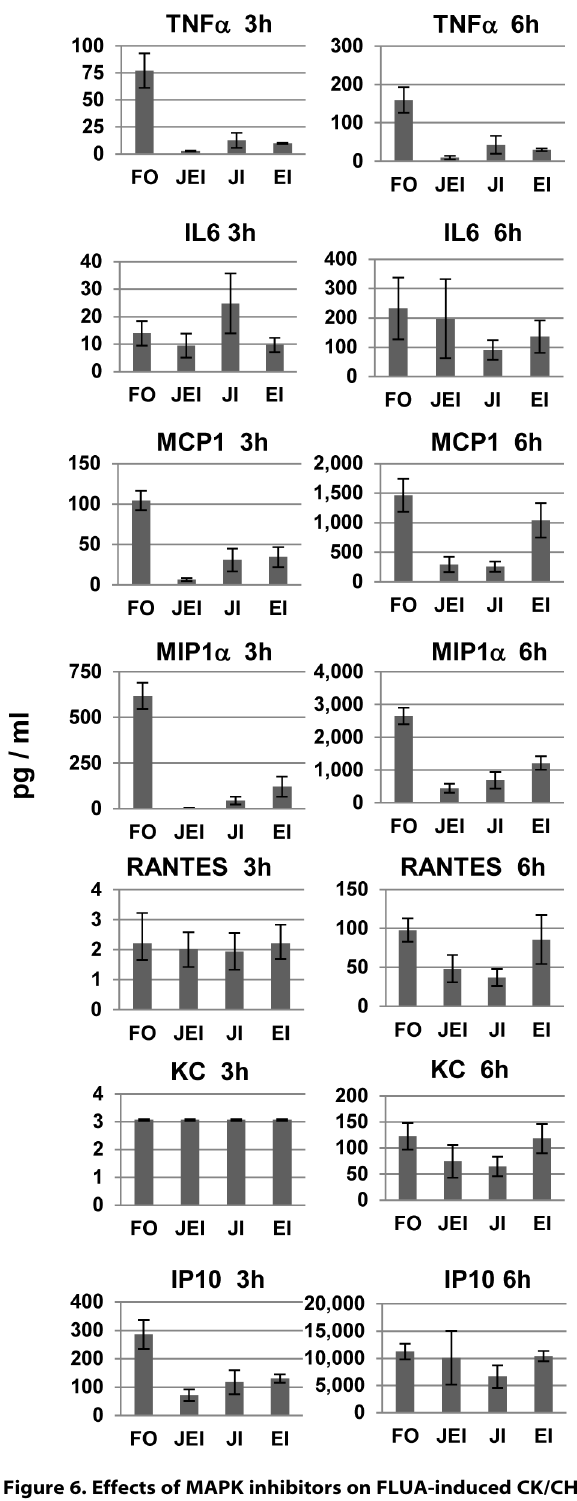
Figure 6. Effects of MAPK inhibitors on FLUA-induced CK/CHKs from J774.A1 cells at short time points. Supernatants from cells pre-treated with the indicated inhibitors for 1 h then exposed to FLUA were collected 3 or 6 h after exposure, along with those from mock infected controls. They were assayed for selected CK/CHK by multiplexed fluid phased antibody based analysis. Cytokine concentra- tions were calculated based on known concentration standards run at the same time. Data shown are the mean 6 SEM, n=3 independent experiments. FO–FLUA only; JEI–both JNK and ERK inhibition; JI–JNK inhibition; EI–ERK